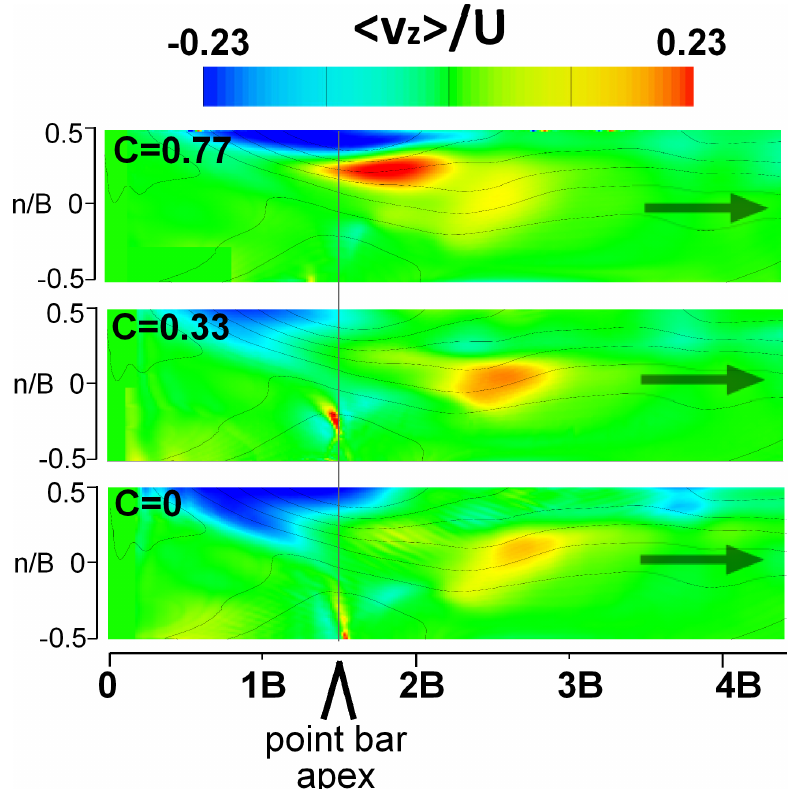
Figure 11. Normalized vertical velocity < v z >/ U for channel curvature C = 0.77, 0.33, and 0 conditions, with positive values upward flows, negative values downward